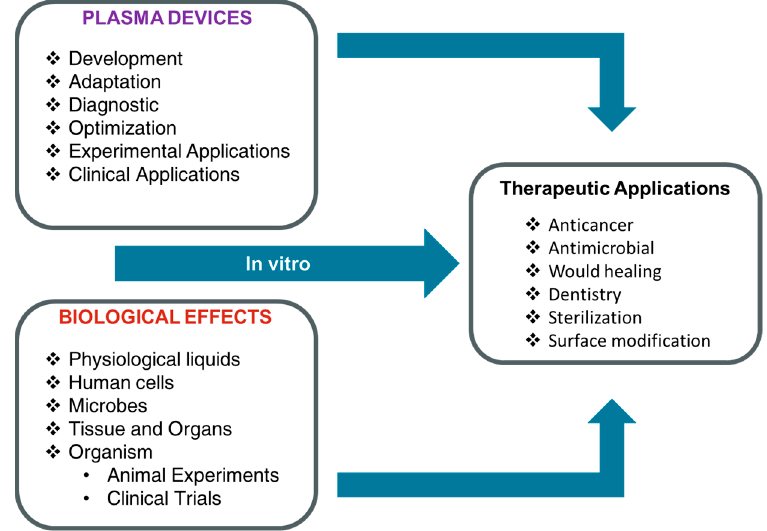
Figure 4. Plasma as reliable and safe therapeutic device for biomedical applications. For safe plasma clinical application, plasma devices and in vitro biological effects must be optimized.